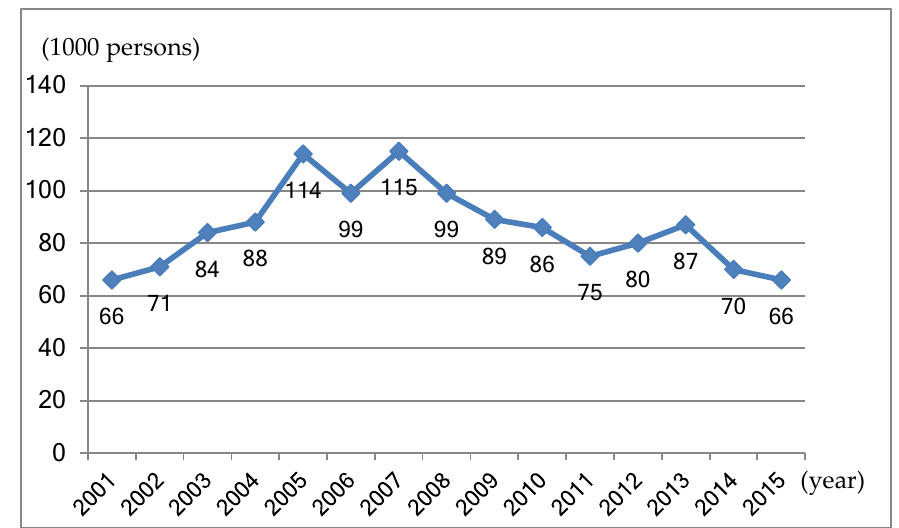
Figure 2. The number of annual new employed individuals with disabilities in urban China areas (2001–2015) Source: China’s Disabled Persons Federation (CDPF). The Disability Cause Development